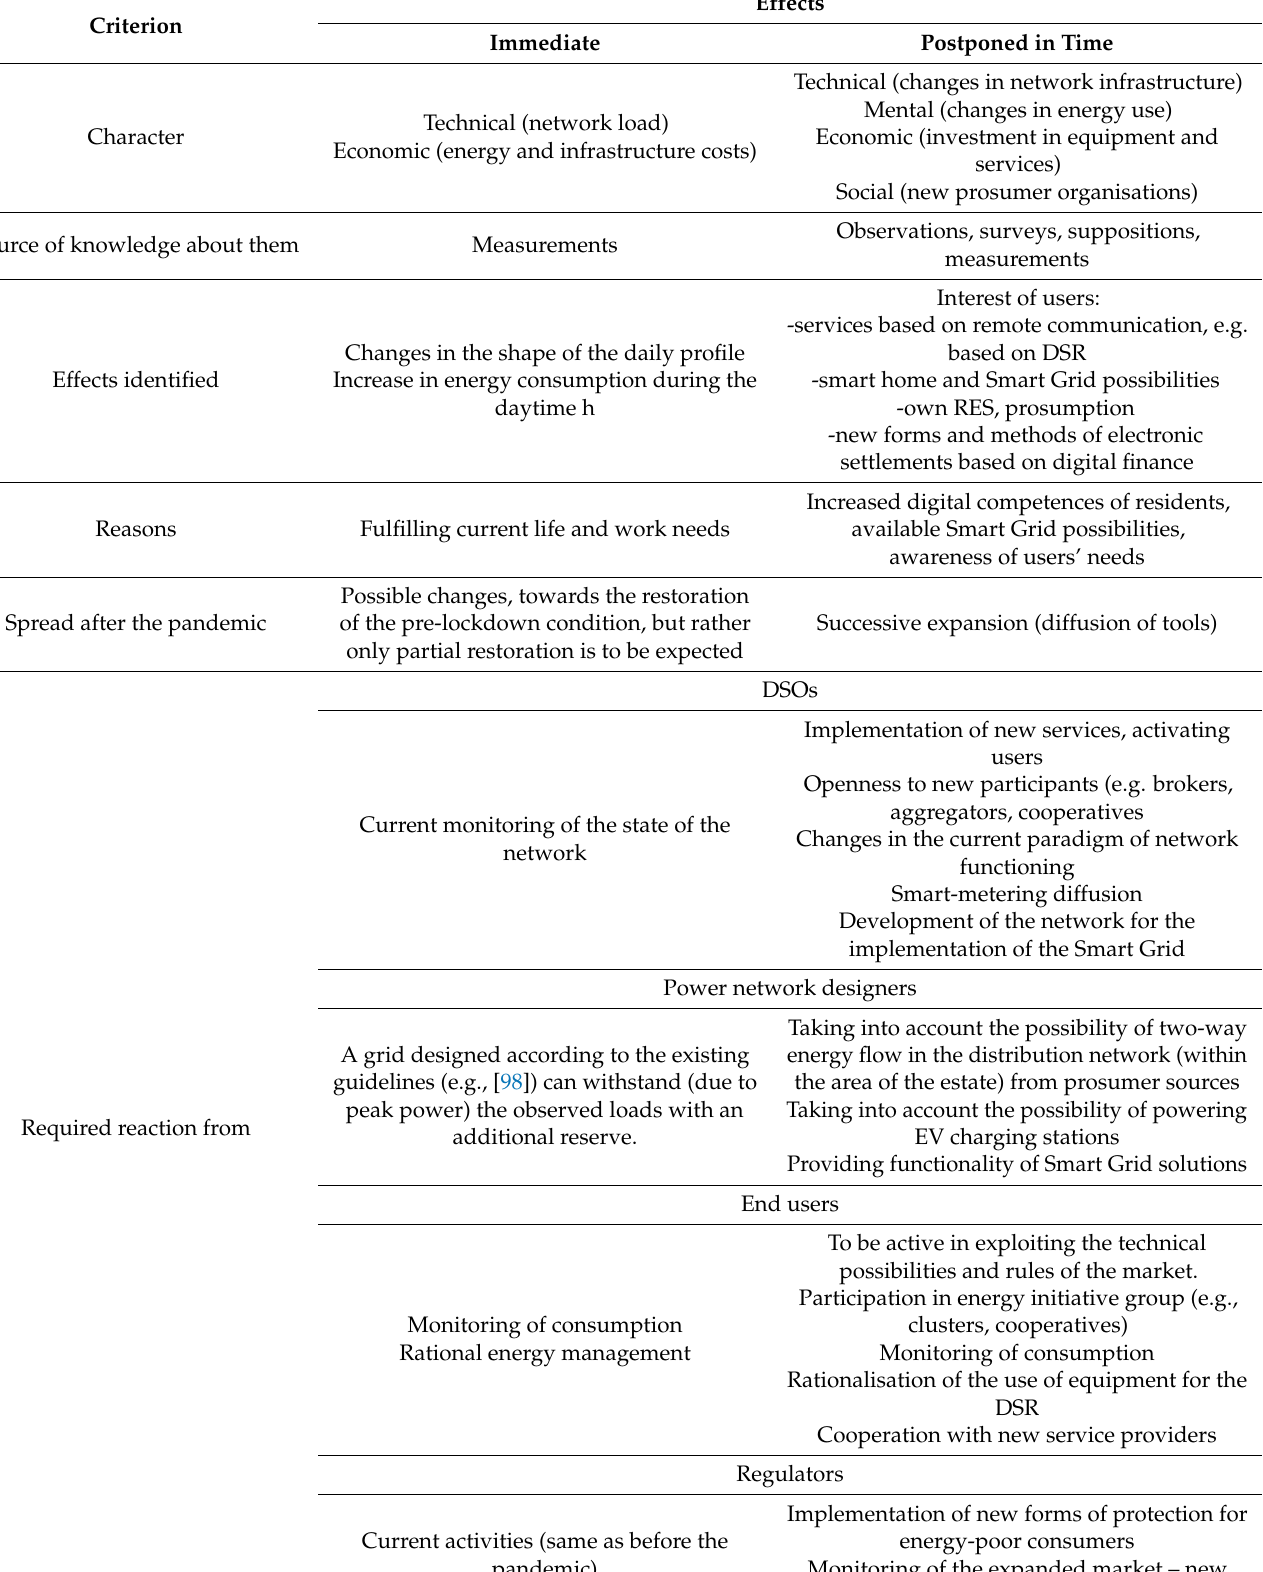
Table 3. Potential impact of a lockdown on the use of electricity in